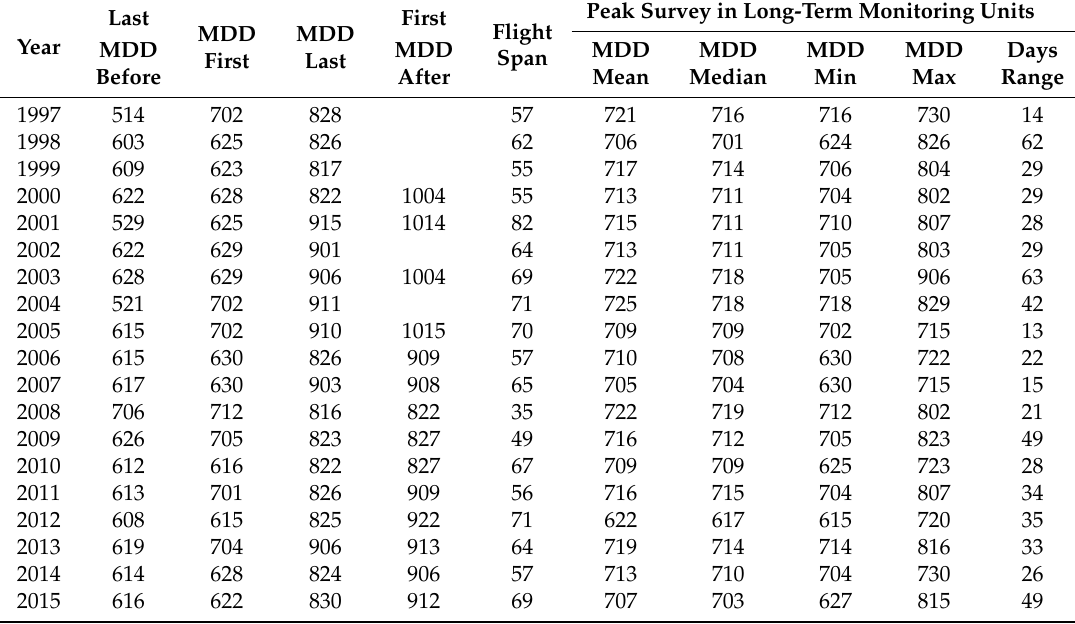
Table 2. Descriptive statistics on regal fritillary flight period and peak dates at Buena Vista Grassland. Dates (MDD, or month-day) indicate last survey date before observed flight period, date of first and last observation, and first survey date after observed flight period. For the long-term monitoring units, dates are provided for the mean and median of the peak surveys, and the minimum (min, i.e., earliest) and maximum (max, i.e., latest) peak survey date.